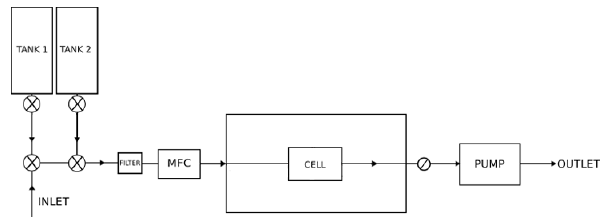
Figure 1. Schematic of FCHAOS, in which air flows from the in- let line through the solenoid valves, past the filter to the mass flow controller (MFC), through the instrument cell, a needle valve, and finally the vacuum pump. When calibrating, the solenoid valves are actuated to direct flow from each individual calibration tank into the cell